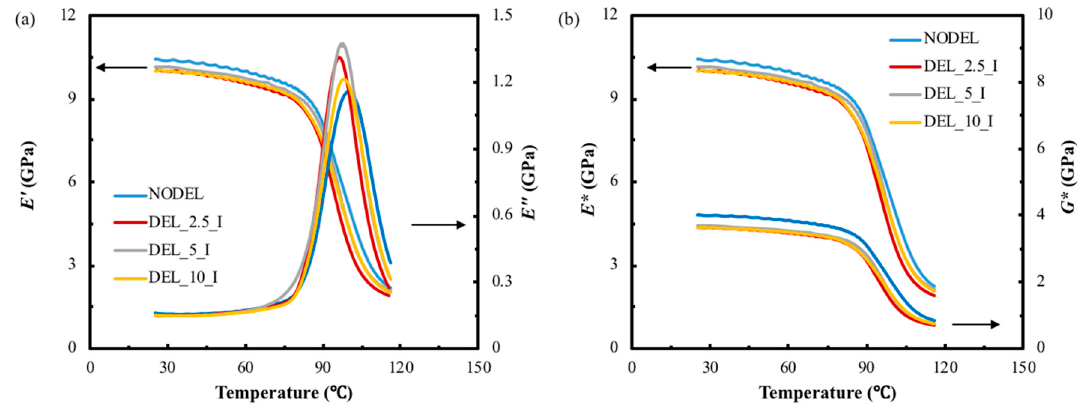
Figure 6. ( a ) Typical storage and lost moduli against temperature curves and ( b ) typical complex storage and shear moduli against temperature curves of flax fiber-reinforced polymer (FFRP_ composite with different delamination